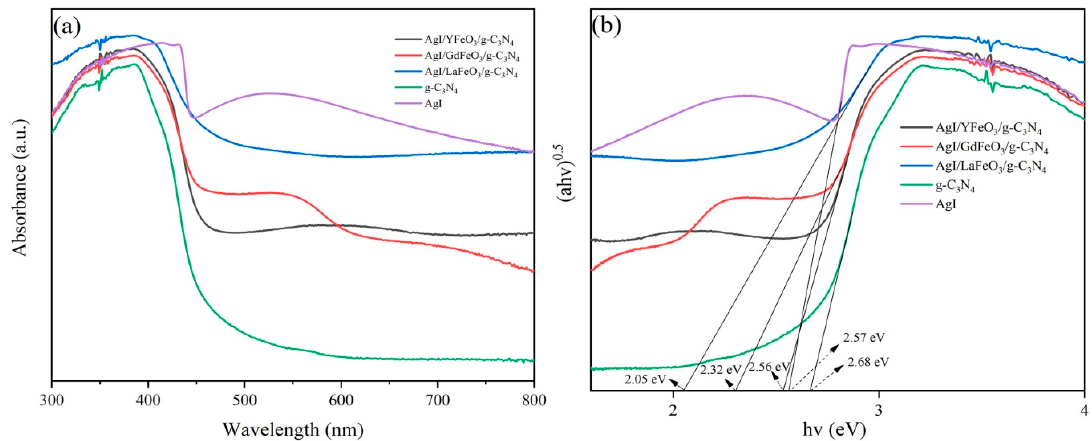
Figure 5. ( a ) DRS of AgI, g-C 3 N 4 and AgI/MFeO 3 /g-C 3 N 4 (M=Y, Gd, La) and ( b ) bandgap calculation of obtained samples.